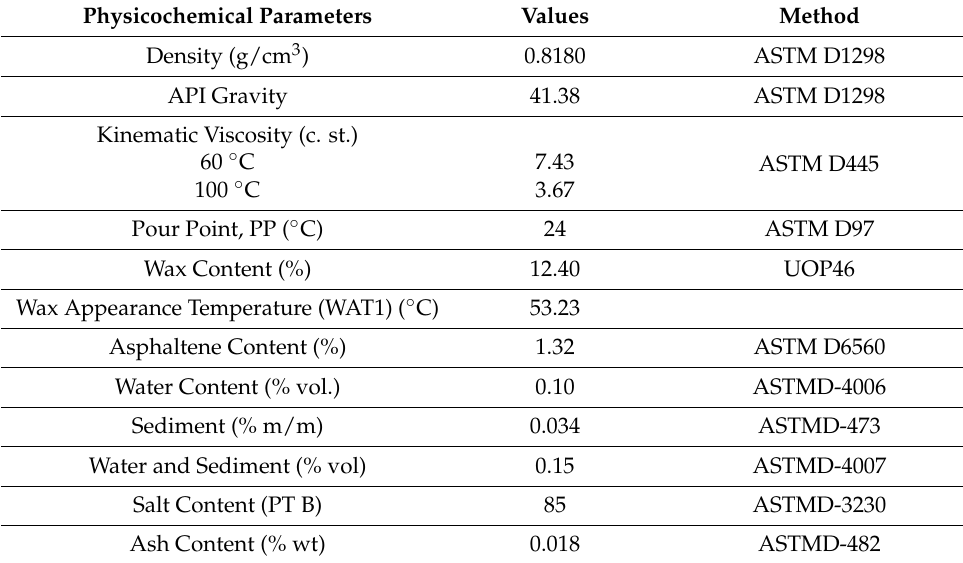
Table 1. Physical characteristics of Alamin crude oil